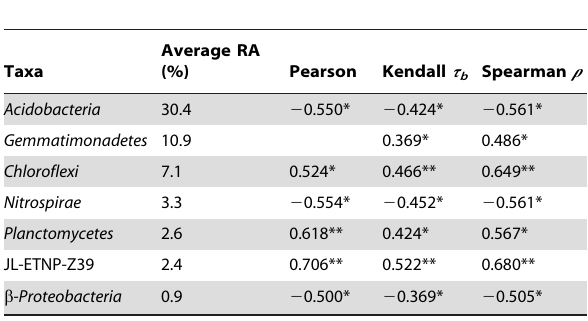
Table 1. Correlation coefficient between abundance of microbial taxa and the year of monoculture a